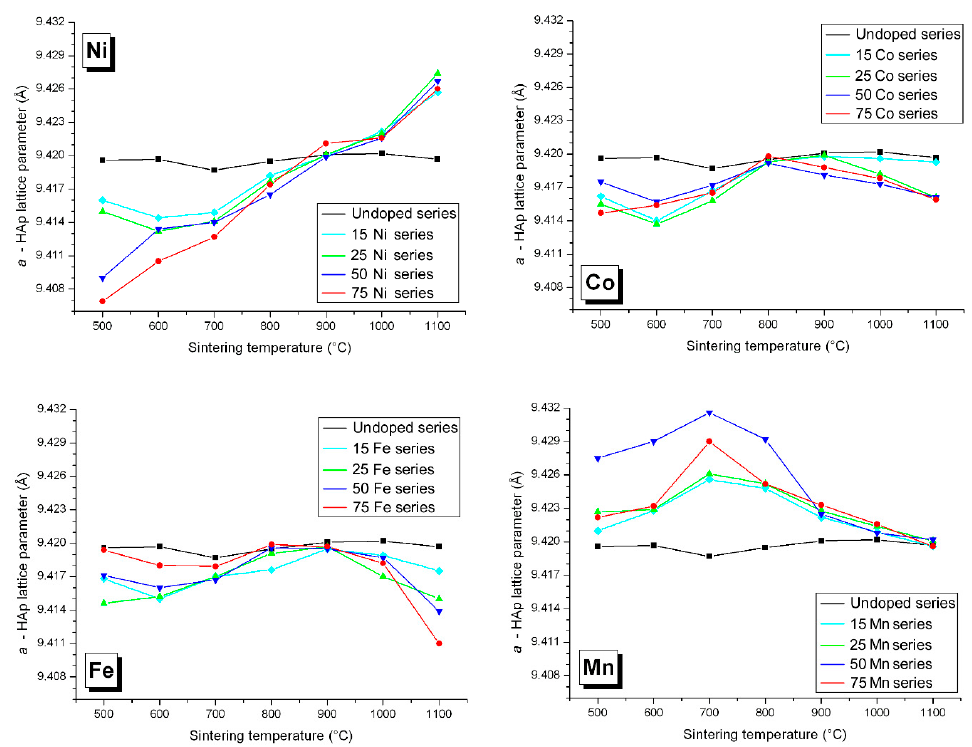
Figure 8. Variation in the basal a lattice parameter of the HAp phase from all Zn-, Cu-, Ni-, Co-, Fe-, and Mn-doped samples: black lines for the undoped series, light blue lines for the 15 M -T series, green lines for the 25 M -T series, dark blue lines for the 50 M -T series, and red lines for the 75 M -T series. The lines are only visual guides.